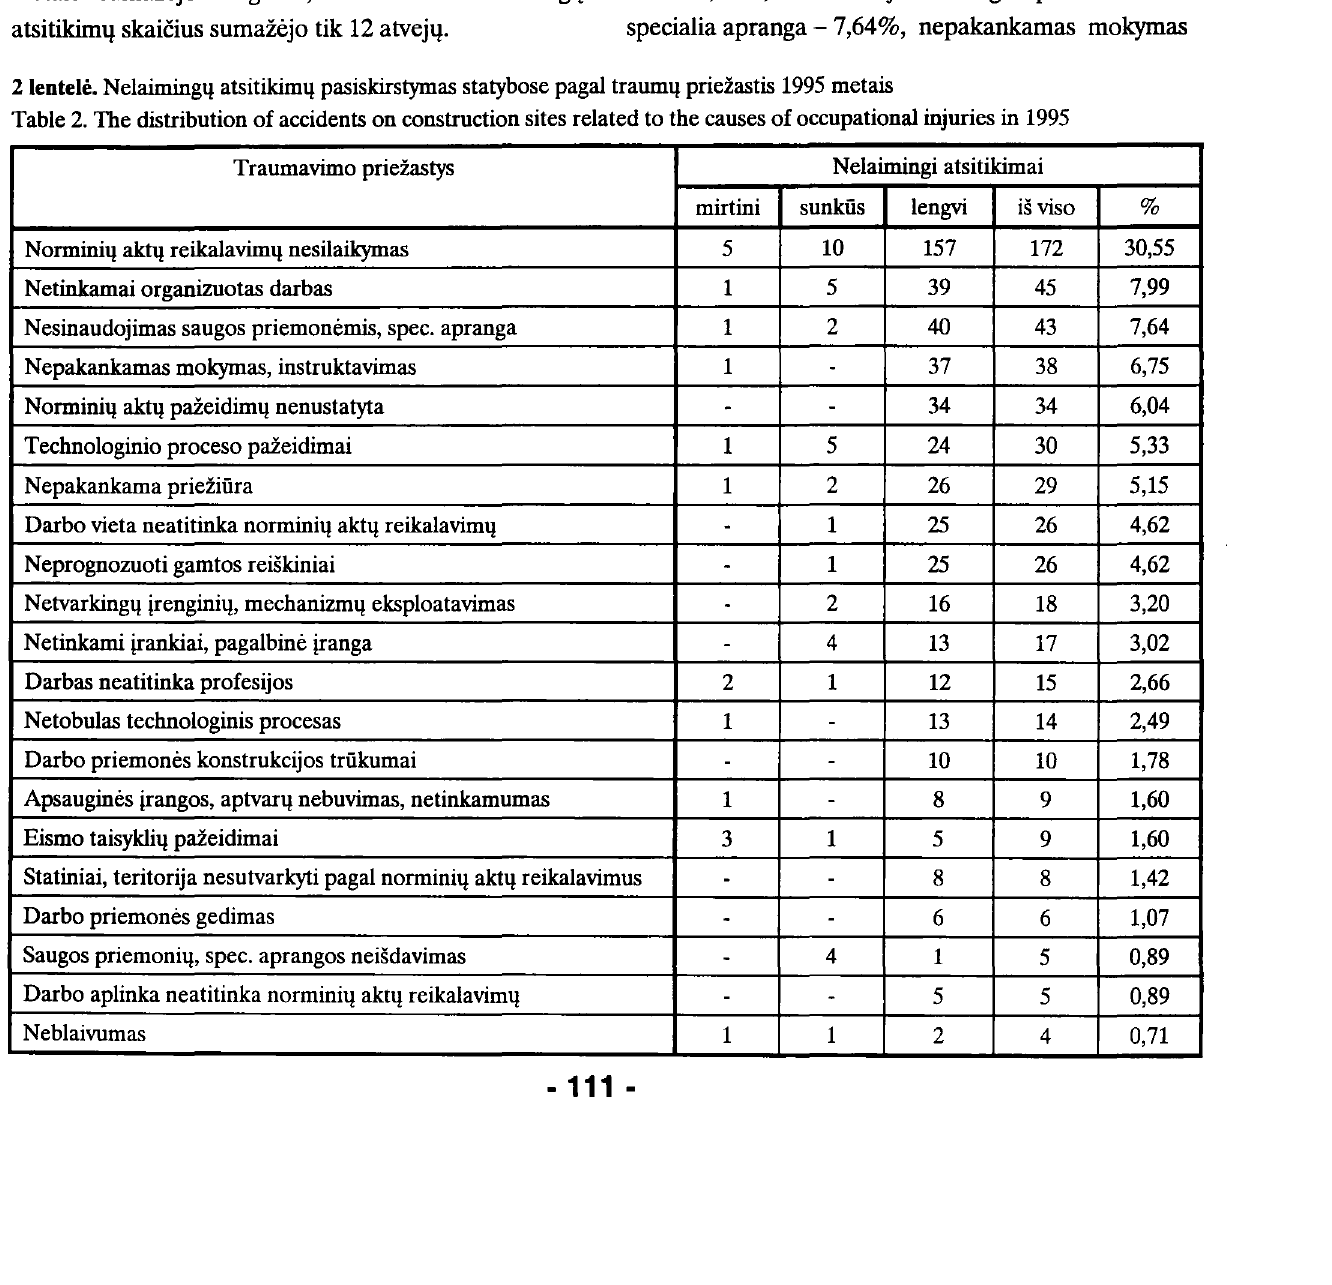
Fig.l. The dynamics of occupational accidents on construction sites in 1991-95